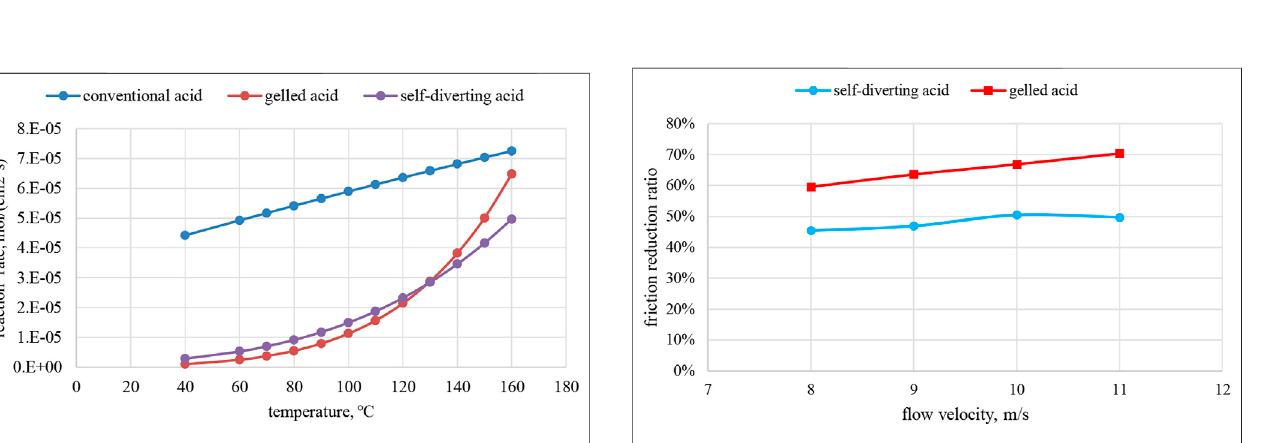
FIGURE 3 | Effect of temperature on the acid reaction rate.